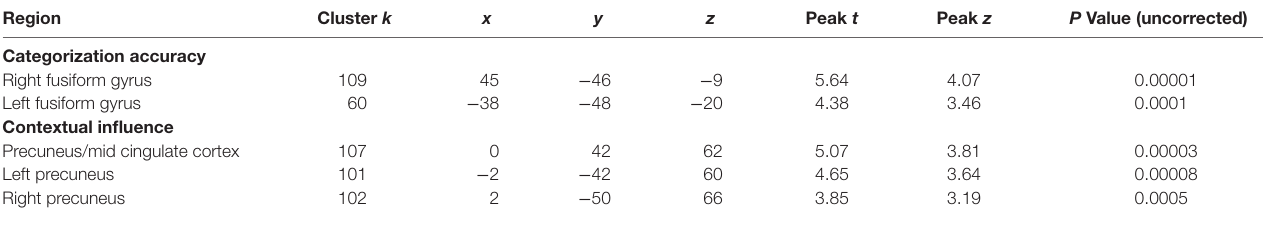
TABLE 5 | Significant brain-behavior associations in AOs.